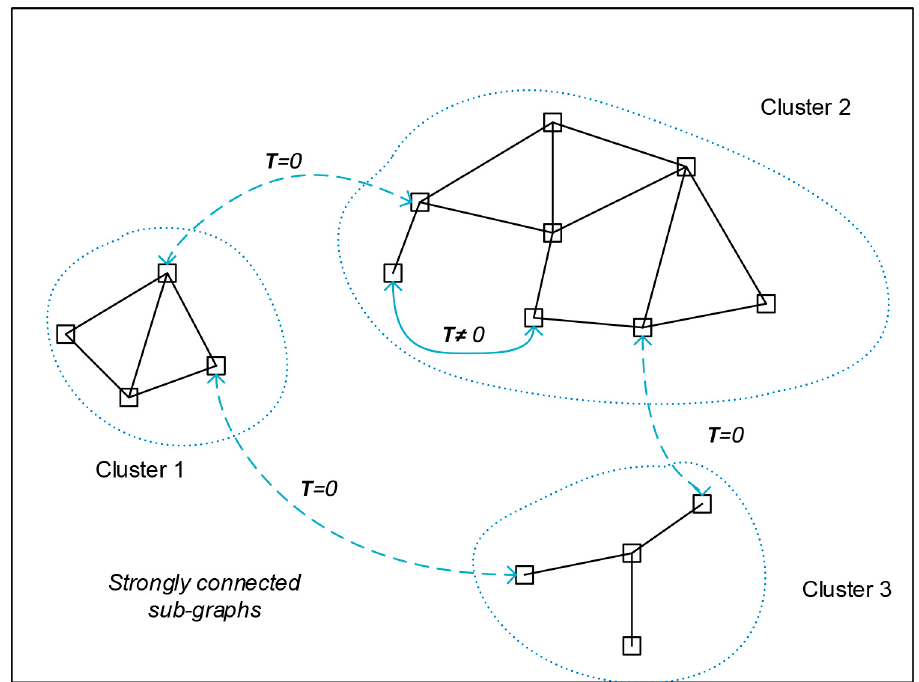
Figure 2. Internodal Transformation and graph connectivity.